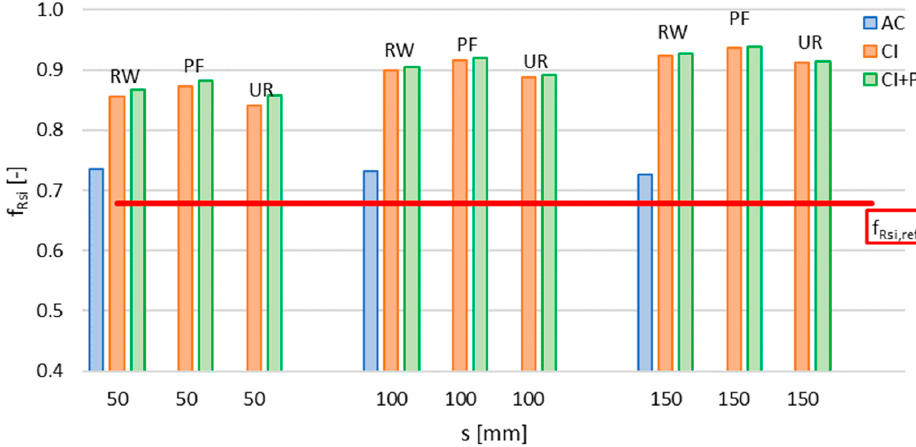
Figure 9. Temperature factor on the thermal bridge f Rsi without pillar.